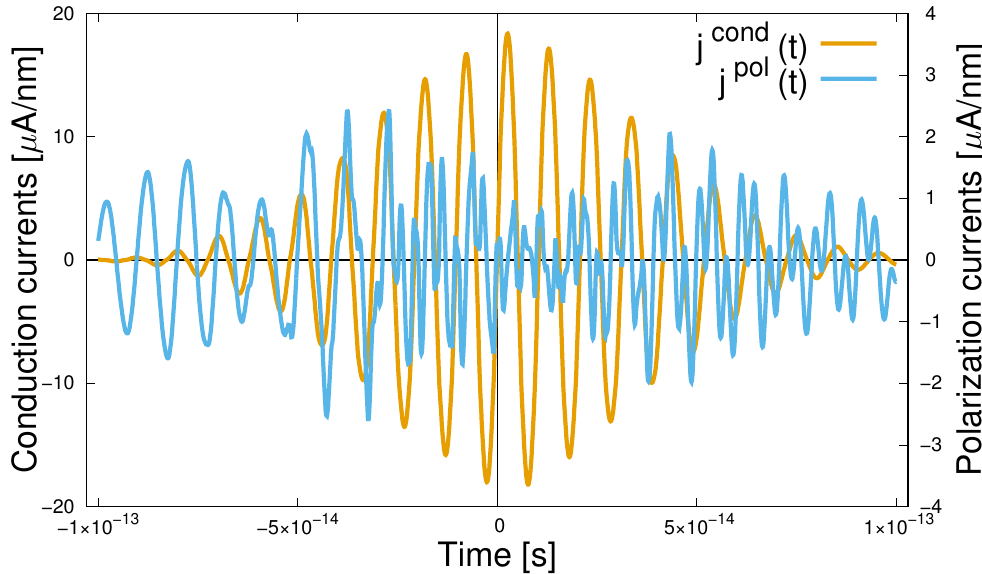
Figure 12. Time dependence of the conduction and polarization currents for a pulsed alternating field with a cyclic frequency ω = 2 π 96.7 ×